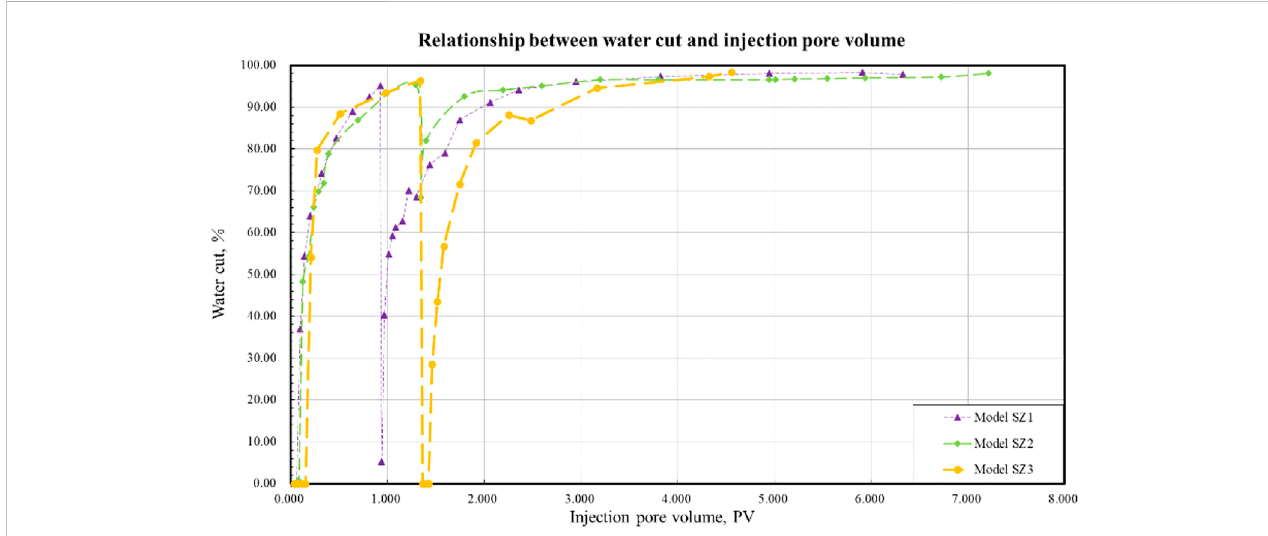
FIGURE 6 Relation between water cut and injection pore volume.